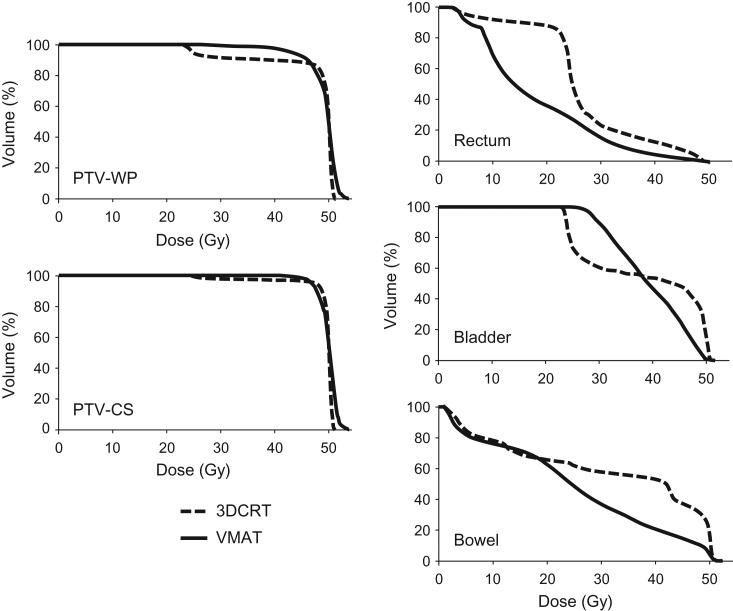
Representative dose–volume histograms of PTV-WP, PTV-CS, rectum, bladder and bowel comparing the 3DCRT plans and VMAT plans in clinical cases.